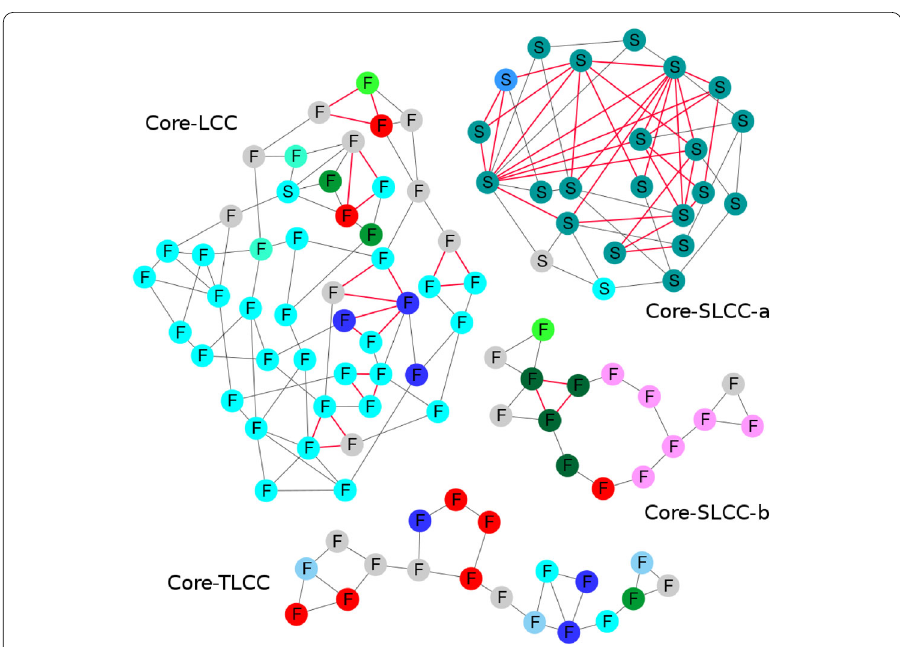
Figure 5 Presence of transitivity. Cores derived from the first four connected components in the network of families shown in Fig. 4. Links that are part of transitive triangles are coloured in red. The label on a node indicates the language that is spoken by the majority of the individuals in the family—Finnish (‘F’) or Swedish (‘S’). Core-LCC: The k max = 3 core of the LCC ( N = 47, L = 86). This subgraph is dominated by nodes from region 17 (Pohjois-Pohjanmaa). Core-SLCC-a: The k max = 3 core extracted from the first of the two second largest connected components ( N = 23, L = 55). Most of the nodes in this subgraph belong to region 15 (Pohjanmaa). Core-SLCC-b: The k max = 2 core extracted from the second of the two second largest clusters ( N = 15, L = 19). Core-TLCC: The k max = 2 core extracted from the third largest cluster ( N = 19, L =